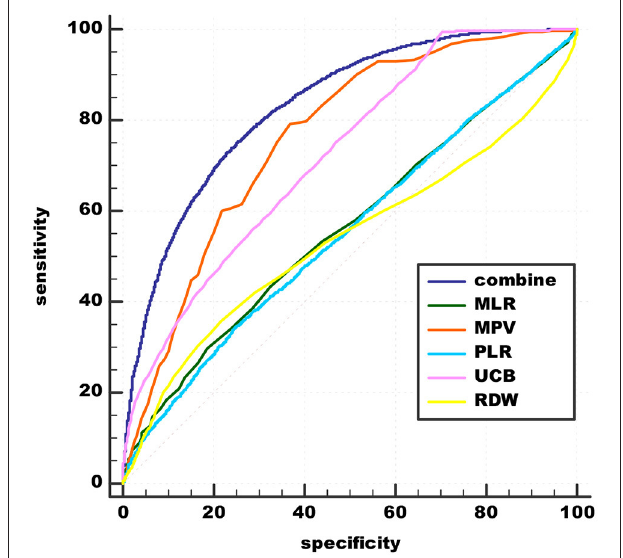
FIGURE 2 | Admission of MLR, MPV, PLR, RDW, UCB, and combinations in predicting acute schizophrenia. UCB, unconjugated bilirubin; MPV, mean platelet volume; RDW, red cell distribution width; NLR, neutrophil/lymphocyte ratio; MLR, monocyte/lymphocyte ratio; PLR, platelet/lymphocyte ratio.